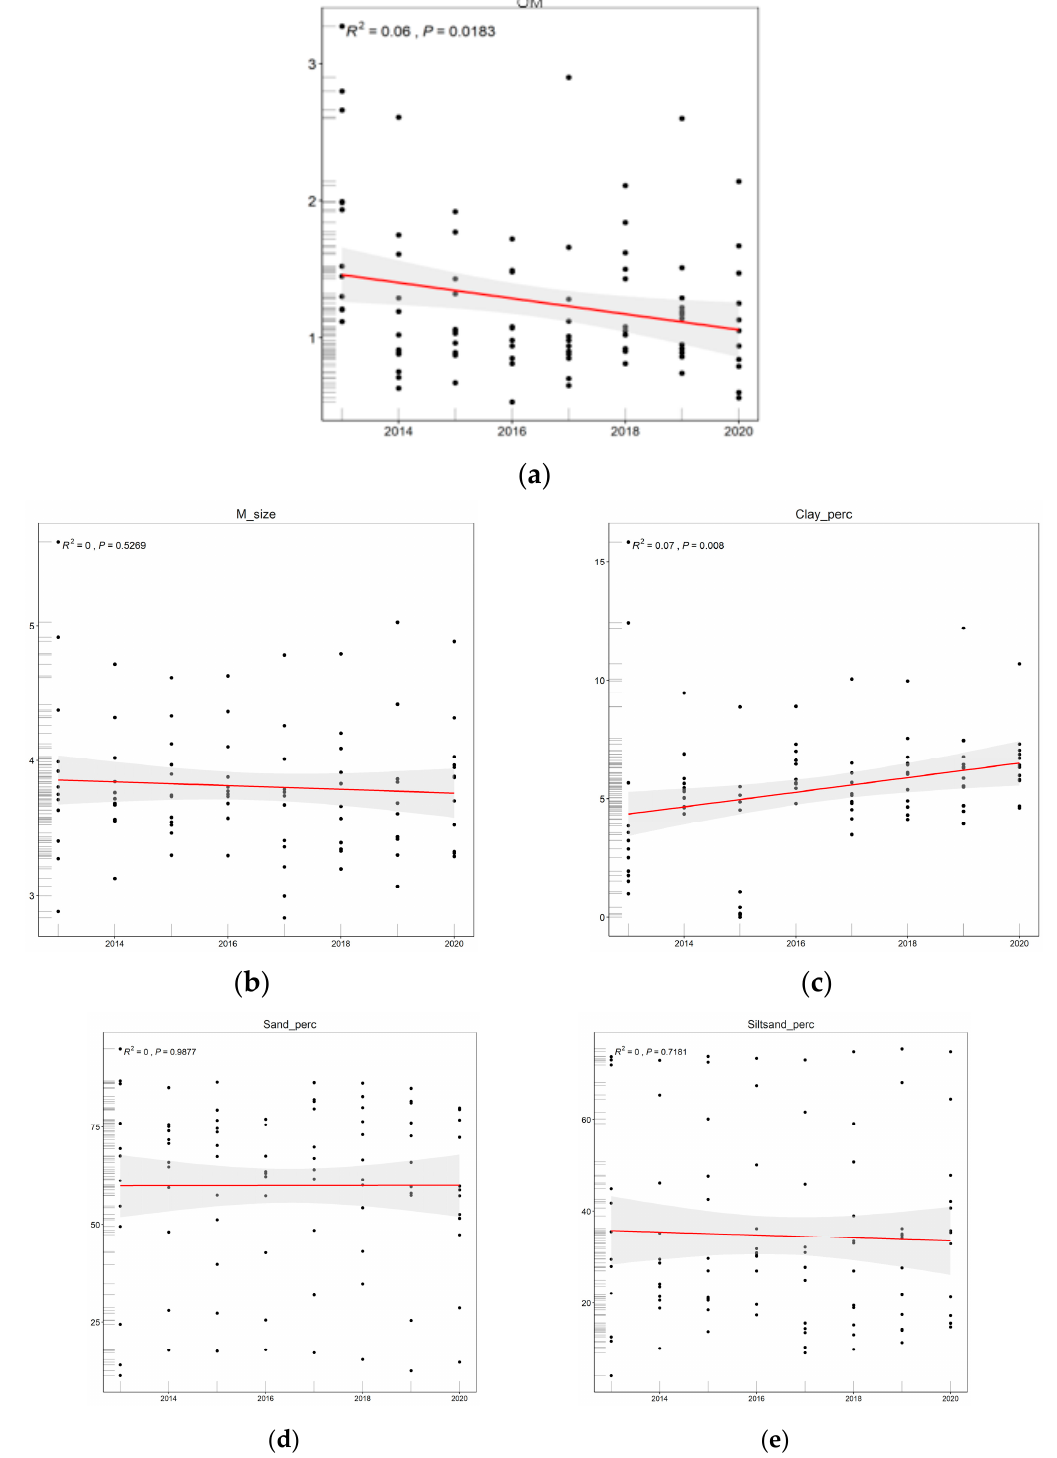
Figure 4. The organic matter ( a ), median grain size ( b ), clay ( c ), sand ( d ) and silt sand ( e ) of sediment in the intertidal flat of Liaohe Estuary from 2013 to 2020. Note: OM, M_size, Clay_perc, Sand_perc, and Siltsand_perc indicates the organic matter content, median grain size, clay content, sand content and siltsand content of sediment, respectively. R 2 and P indicate the fitting degrees and credibility of the linear regression equations, respectively.